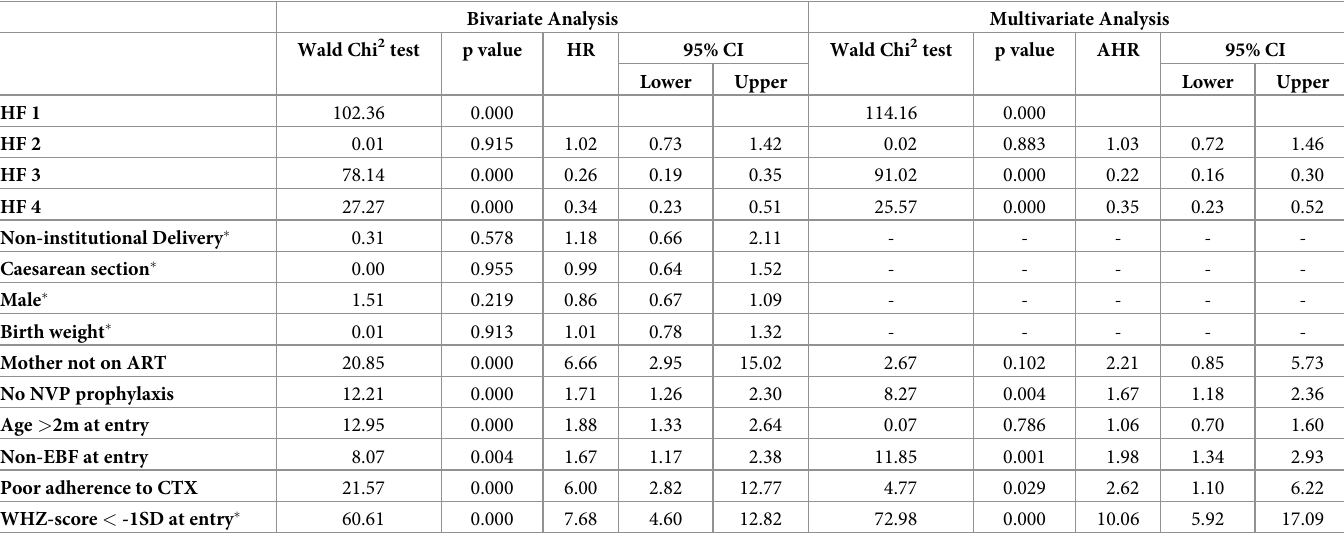
Table 4. Factors associated with the presence of a clinical event during